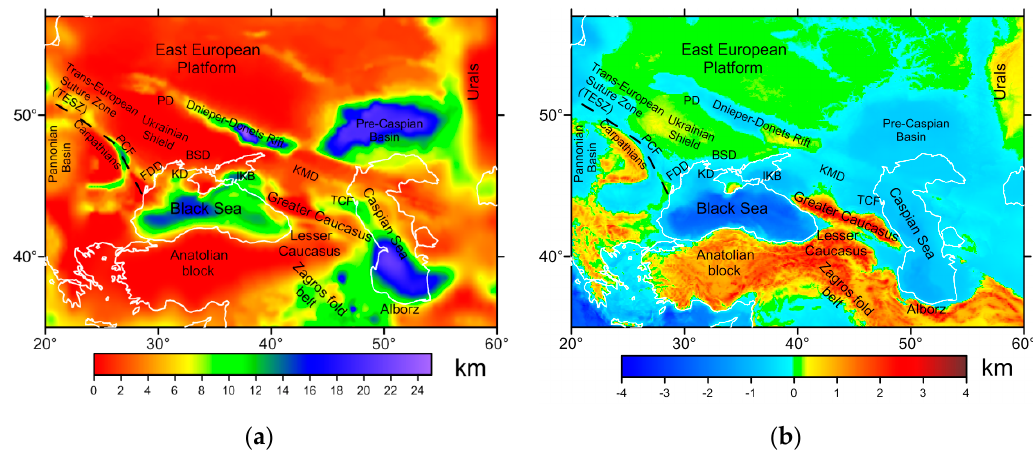
Figure 3. ( a ) Thickness of sediments according to the initial model; ( b ) adjusted topography calculated by numerical “densification” of water and sedimentary tocks to the normal upper crust density (2.67 g/cm 3 ).